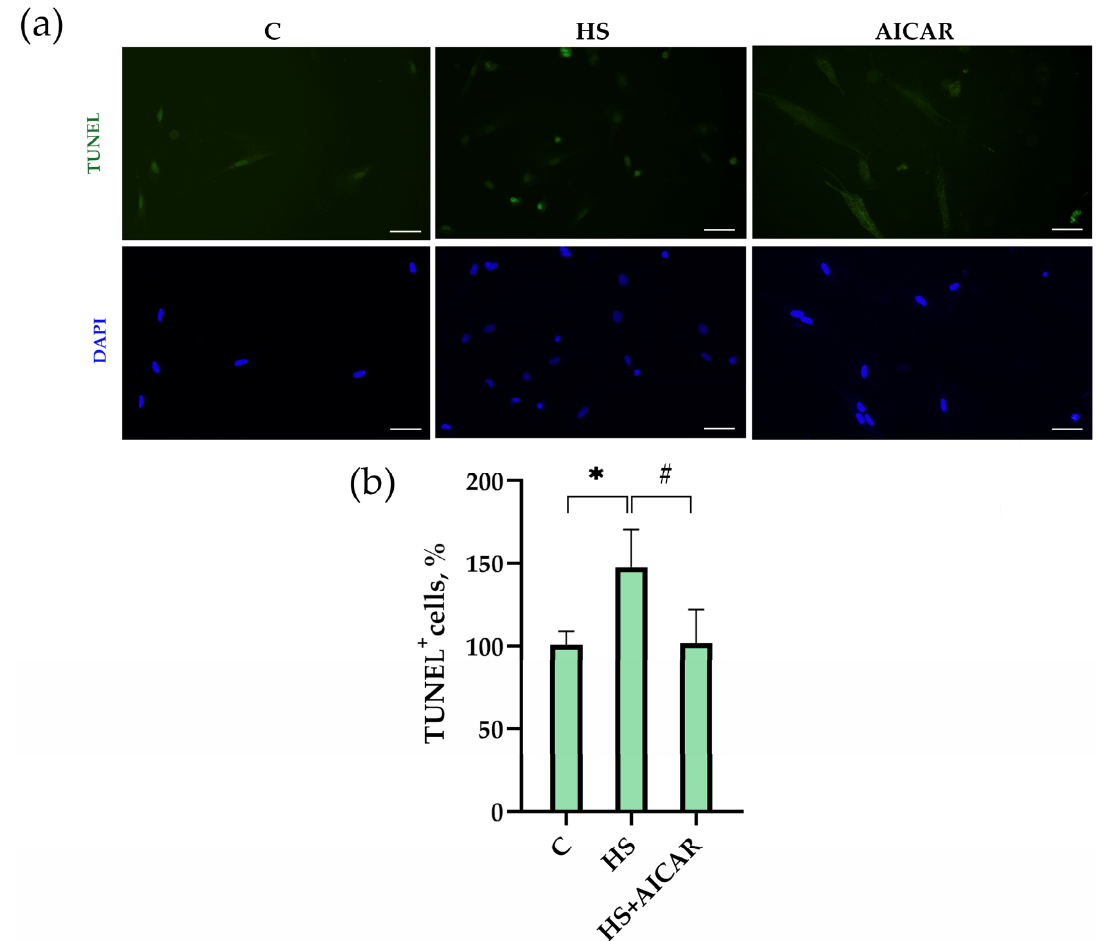
Figure 3. Effect of AICAR treatment on the number of apoptotic cells in differentiating myoblasts derived from the atrophied rat soleus muscle. ( a ) Representative images of TUNEL-stained (green labeling) and DAPI-stained (blue labeling) myoblasts are shown above the graph. ( b ) Quantification of TUNEL-positive cells. Scale bar= 50 μm. C—myoblasts derived from rat soleus muscle of the control rats, HS—myoblasts derived from rat soleus muscle after 7-day HS, HS+AICAR—myoblasts derived from rat soleus muscle after 7-day HS and treated with AICAR. Values are means ± SEM, expressed as % of the C. *— p < 0.05 vs. C; #— p < 0.05 vs. HS.